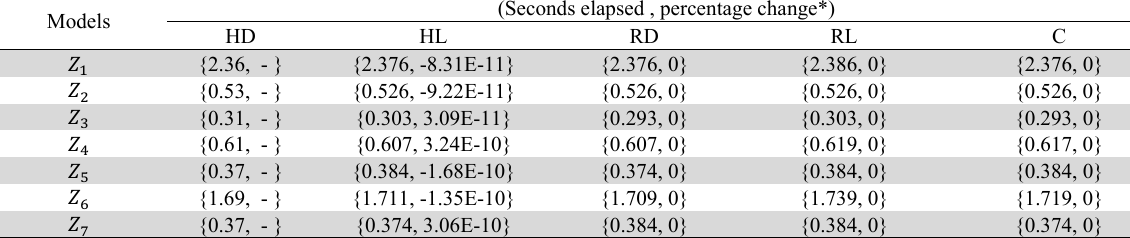
Algorithm results using the recommended starting points.